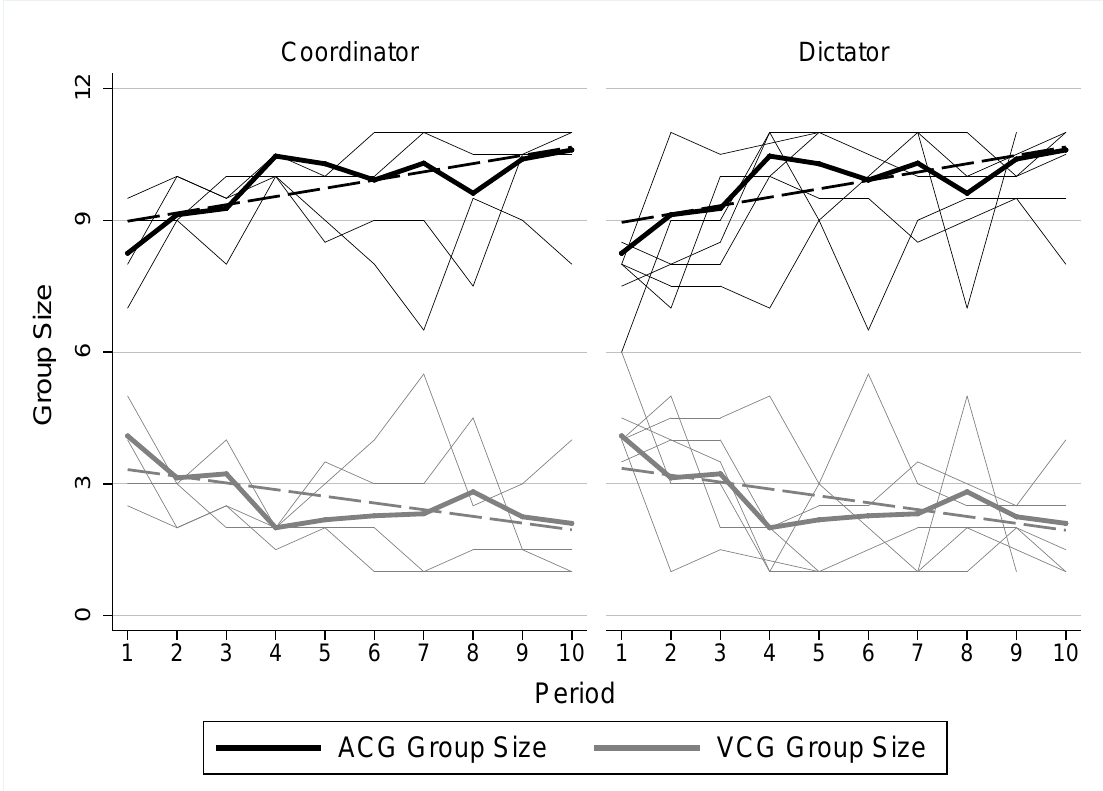
Figure 4. Overall trend in average group size over time in the two treatments. The figure displays the average group size in each of the ten periods separately for the dictator and the coordinator treatments. The data of rounds 1 and 2 are pooled. The dashed lines are linear predictions. The thin lines are average group sizes in individual